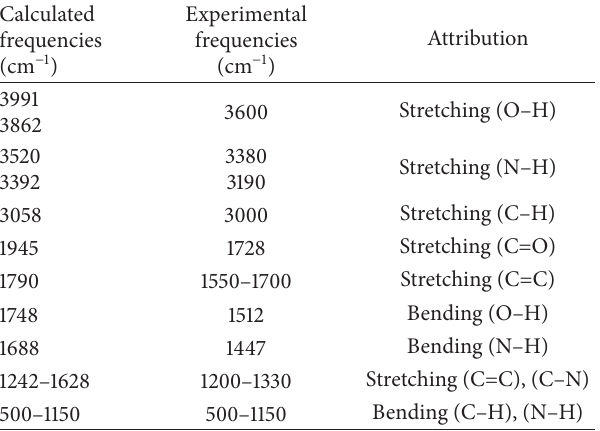
Figure 5: Calculated IR spectrum of compound 2C 13 H 12 N 2 O ⋅ H 2 O. Table 4: Calculated and experimental IR bands.